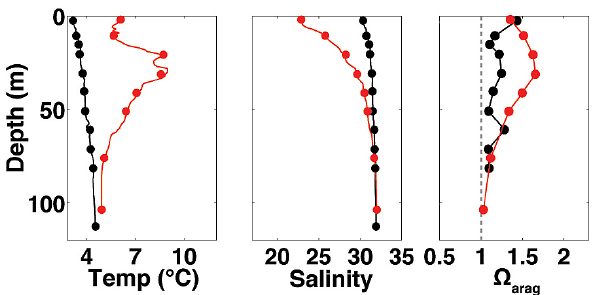
Fig. 8. Depth profiles of temperature (left; ◦ C), salinity (middle) and (cid:127) arag (right) collected in Columbia Bay (Fig. 1) during spring 2012 (black) and autumn 2012 (red). The vertical gray dashed line in the right panel denotes the (cid:127) arag = 1 level below which dissolution of aragonite will occur. Temperature and salinity traces are from CTD downcasts, and dots are the measurements made at the depth Niskin bottles were fired during